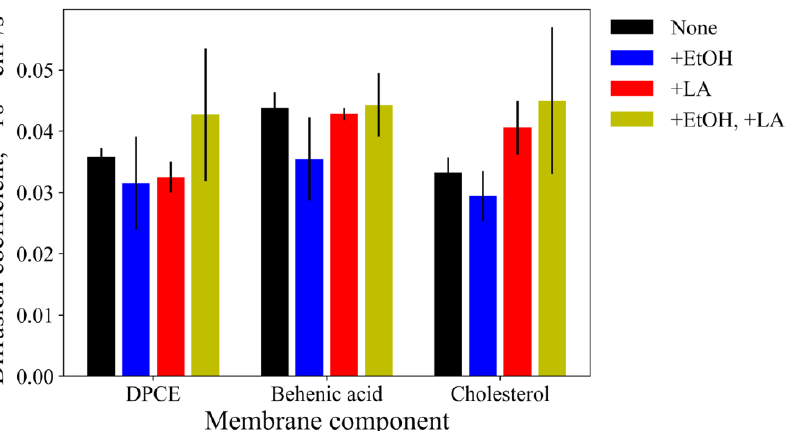
Figure 4. Diffusion coefficients of the individual membrane components: DPCE, behenic acid, and